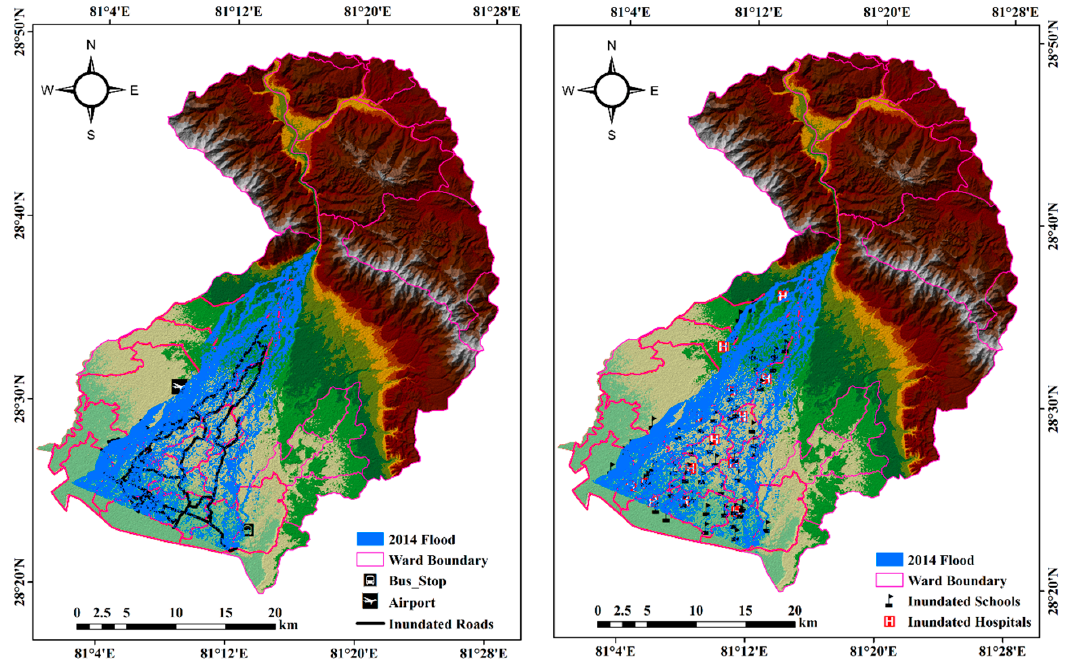
Figure 14. Spatial distribution of major transportation routes (airport and bus stops) ( left ) as well as the health centers and schools ( right ), which were inundated by the simulated 2014 floods between Chisapani station and the Nepal–India border.